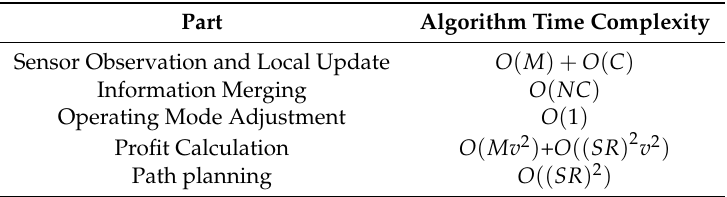
Table 2. Complexity analysis of each parts of the proposed